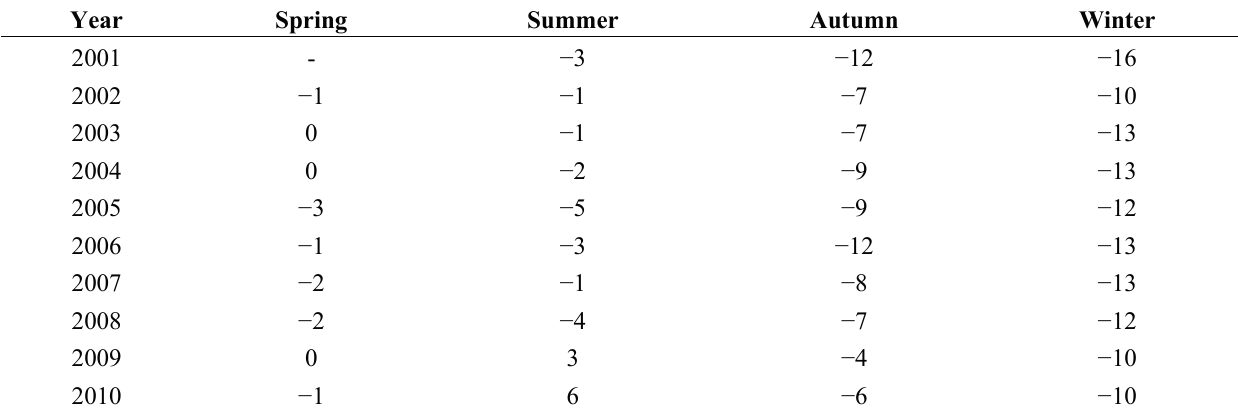
Table A1. Relative percentage errors (RE) of the seasonal FPAR from 2001 to 2010 at the study site. Negative values represent underestimate and positive ones overestimate.